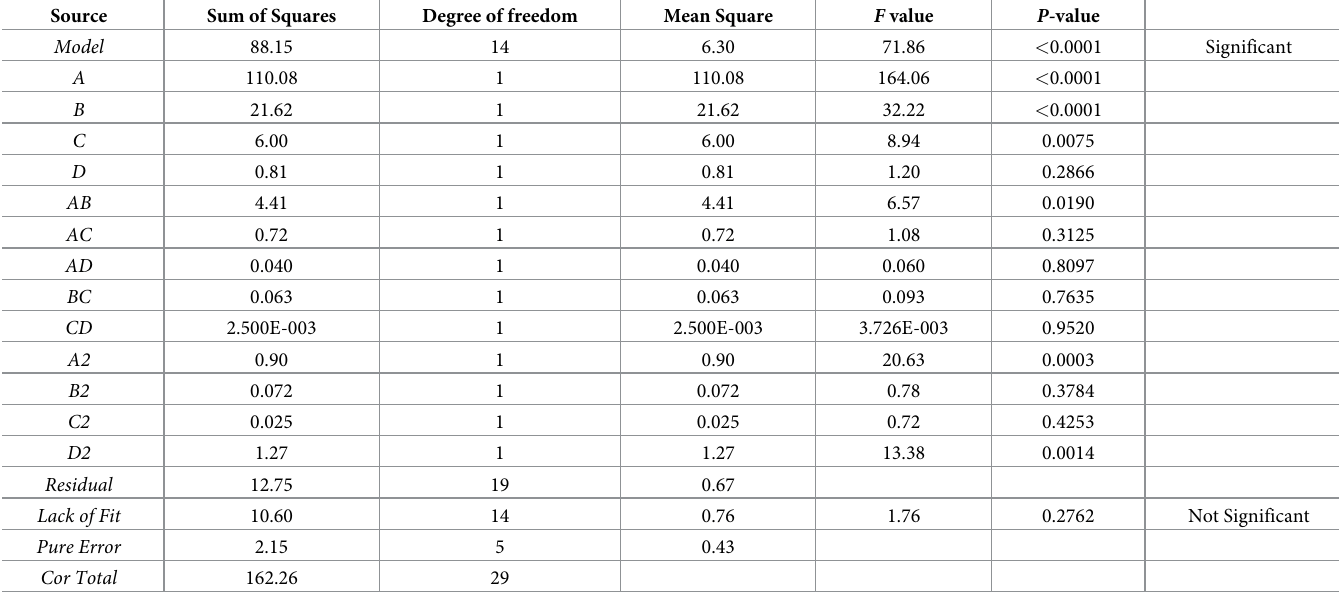
Table 5. Variance analysis of regression